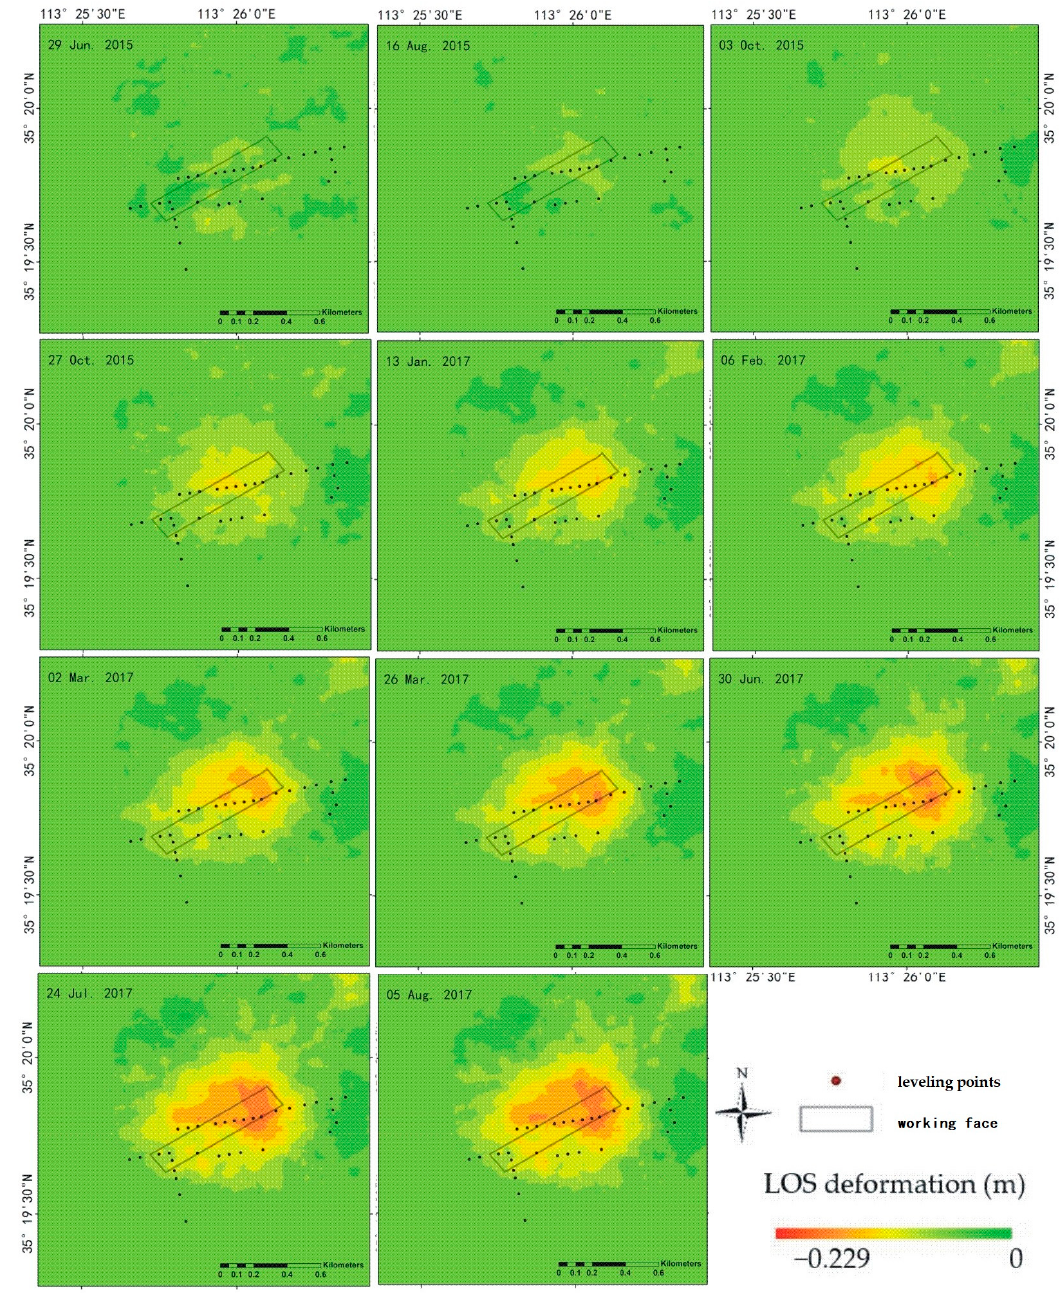
Figure 8. Typical figures of accumulative deformation. The subsidence center deviated toward the mining direction. After we calculate the accumulated deformation of the coal mine, the dynamic infor- mation on coal-mining subsidence could be clearly illustrated by time series profiles. In this study, we established two profiles along the strike and dip directions and extracted every profile during the observation period (Figure 9). Over time, the surface above the coal mine sank gradually. The subsidence profiles are almost symmetrical at the center and decrease from the center to the edge. There are some differences between the shapes of the two profiles. The length of the strike profile is longer and more symmetrical than the dip profile. Hence, the subsidence on the ground is related to the shape of the working face underground. This characteristic is applied to the proposed method in an integral function to simulate reasonable